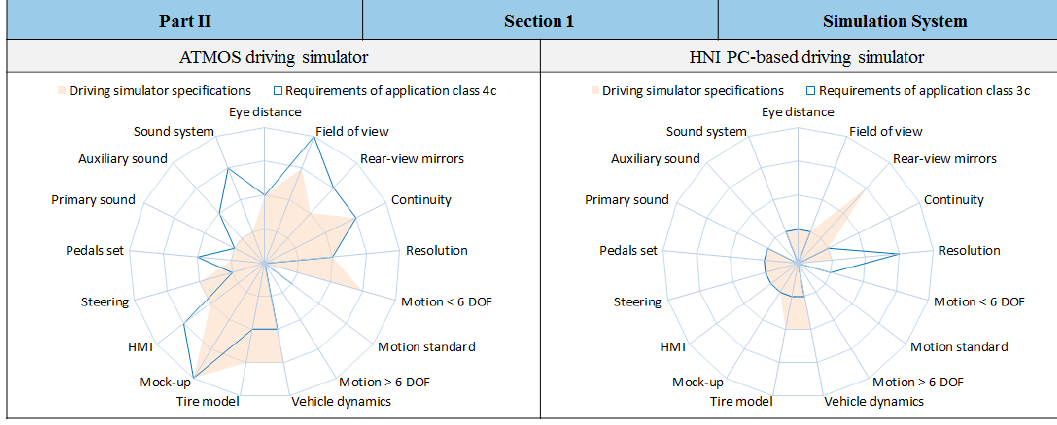
Figure 14. Established platform of networked driving simulation for the first application scenario. The HNI PC-based driving simulator shown at the left side within Figure 14 has no motion platform. This driving simulator has a commercial wheel–transmission–pedals set and a simple driving seat. It utilizes a 60-inch high-definition screen. The HNI PC-based driving simulator is operated by a software package developed with MATLAB/Simulink. The ATMOS driving simulator shown at the right side within Figure 14 has a complex motion platform consisting of two dynamical components. The motion platform provides five Degrees Of Freedom (DOF) to fully simulate vehicle lateral and longitudinal accelerations. The ATMOS driving simulator has an eight-channel cylindrical projection system. It is powered by eight LCD-projectors to cover a horizontal field of view of 240 degrees. In addition, three small displays are used to simulate the side and rear mirror views. The ATMOS driving simulator is operated by a software package developed by the company dSPACE in Germany. The platform shown in Figure 14 adopts the mixed-fidelity concept [38]. That is, two